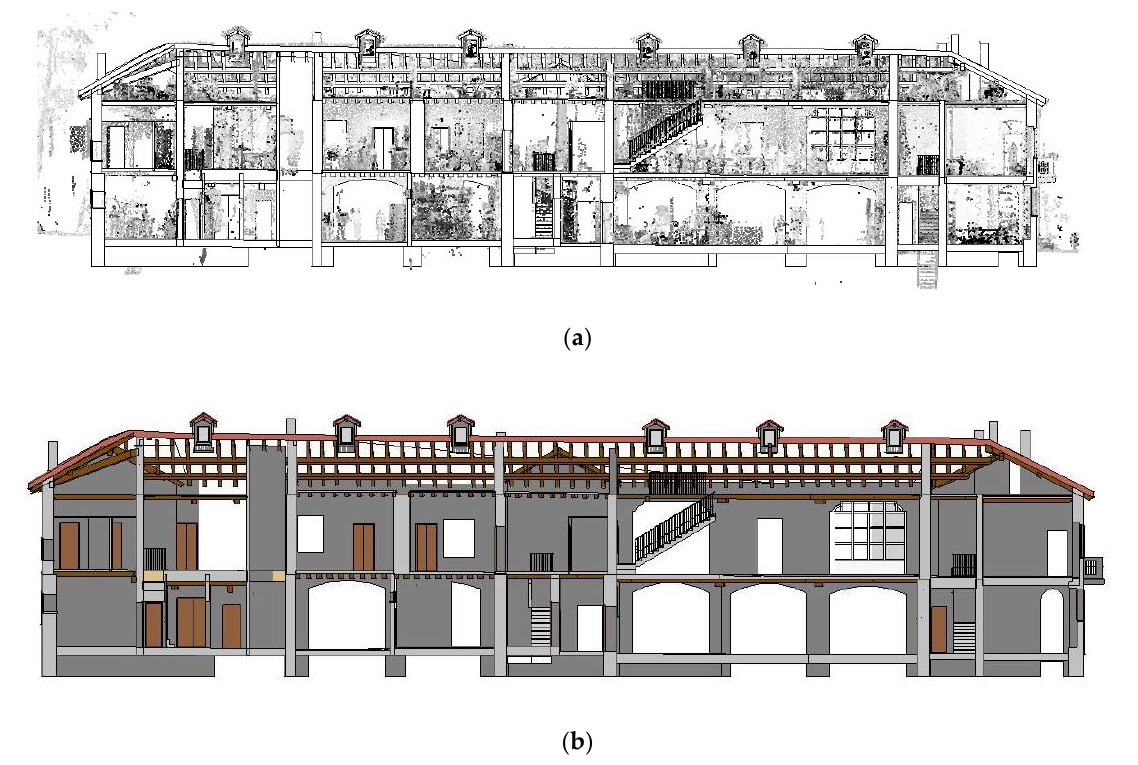
Figure 1. CAD (Computer-Aided Design) geometric survey obtained from a points cloud: ( a ) cloud resolution; ( b ) CAD re-drawing of the transversal section.